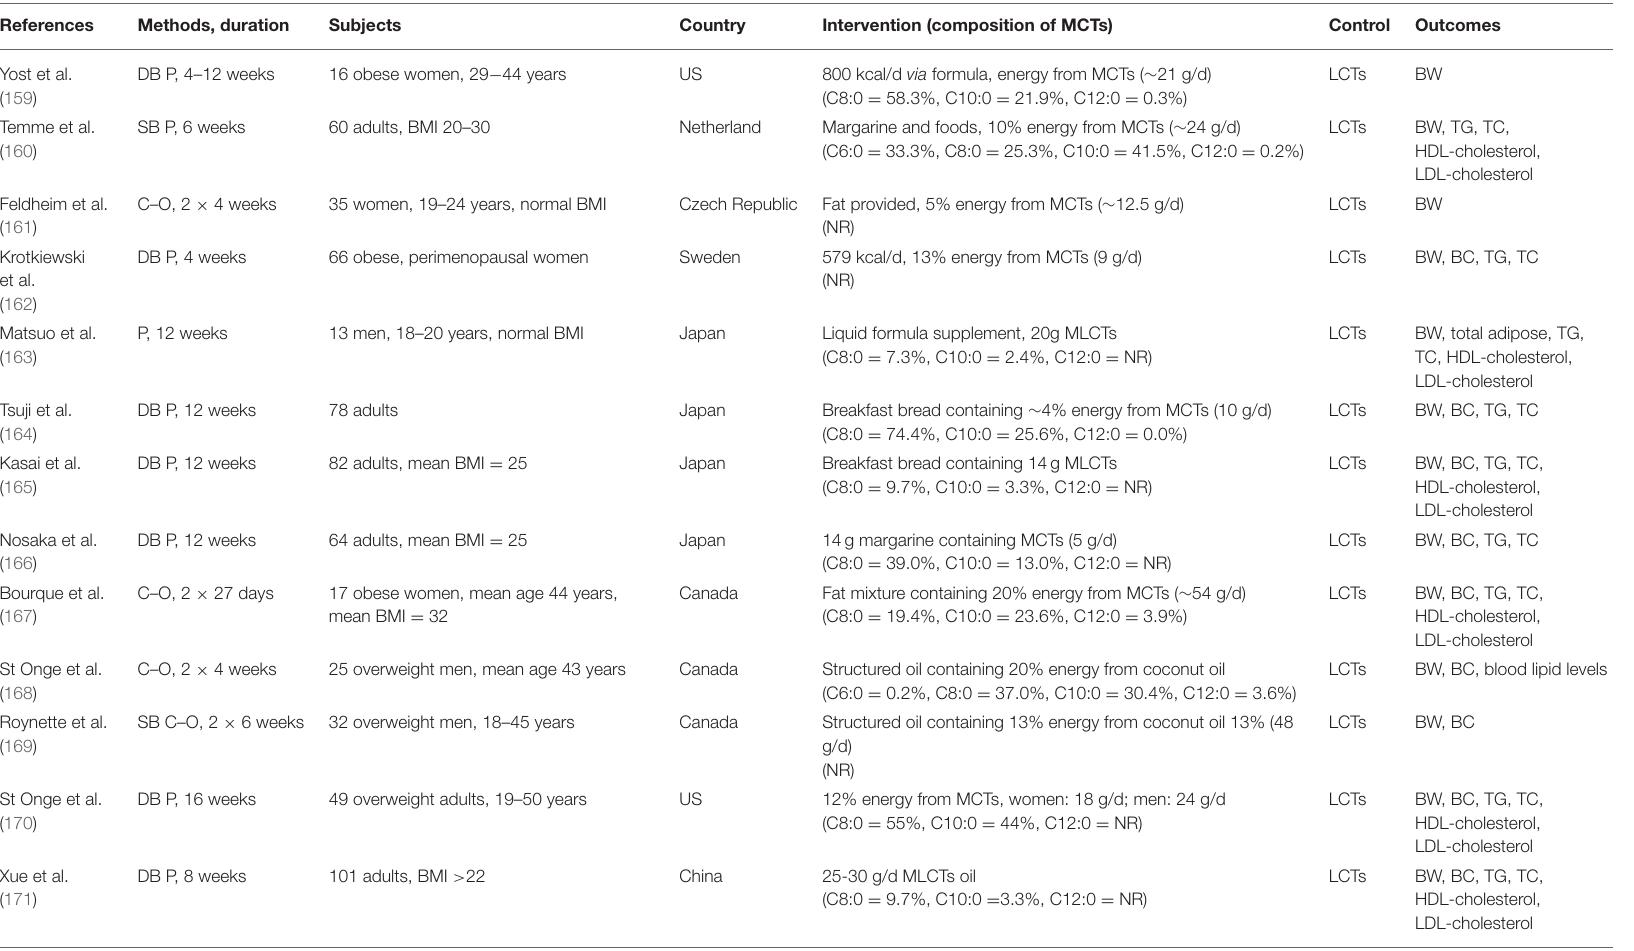
TABLE 4 | List of reports on the effects of MCFAs ingestion on body weight, body composition, and blood lipids [modified from Mumme and Stonehouse